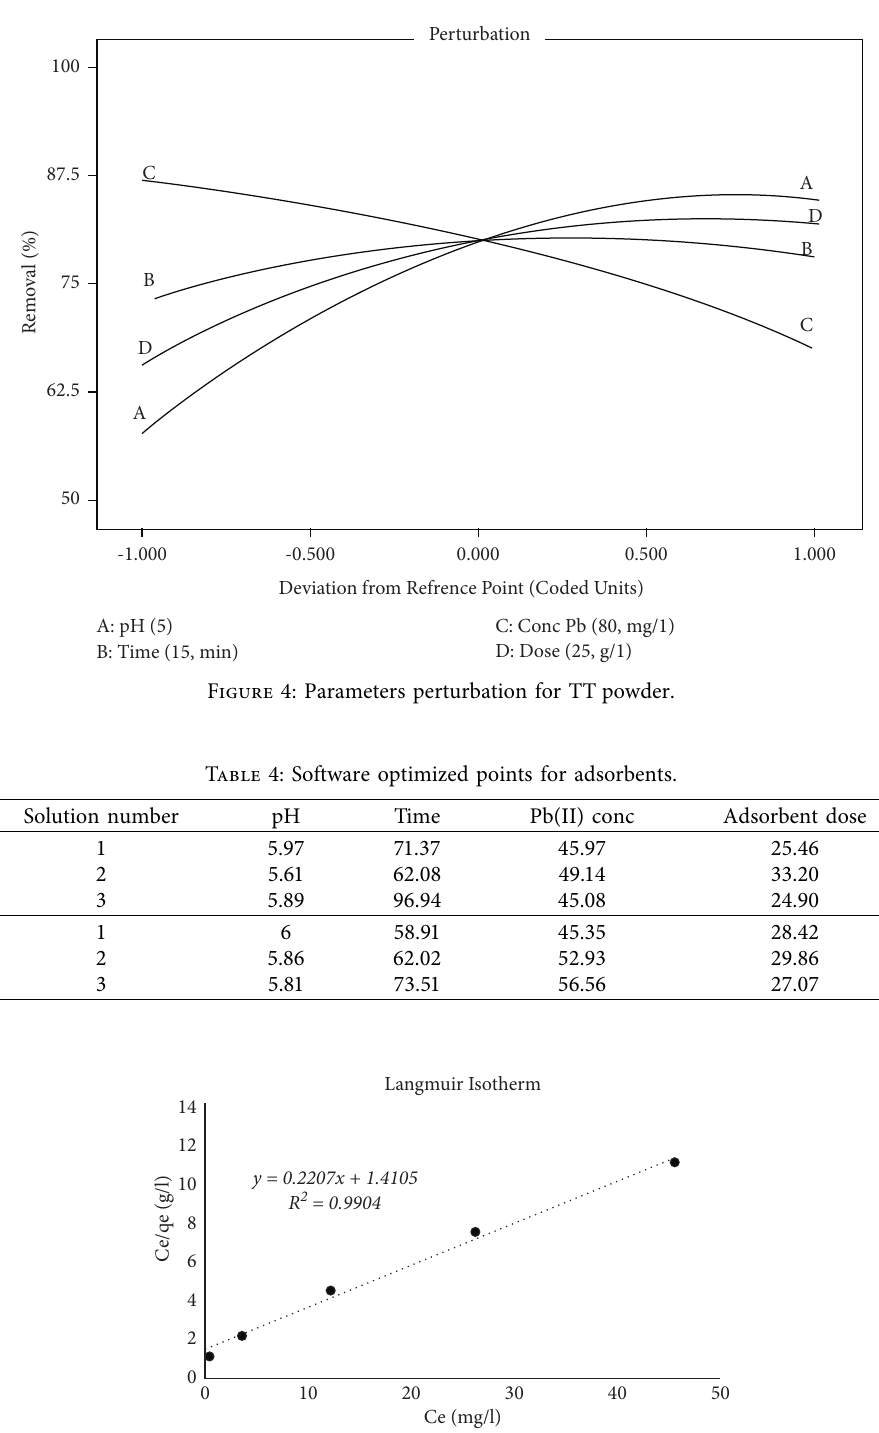
Figure 5: C e / q e variations to C e , Langmuir isotherm, MG